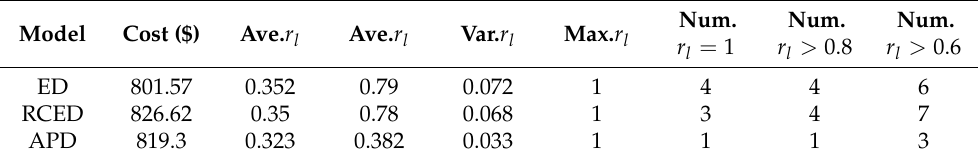
Table 1. Comparison of power flow distribution indices of different power dispatch models tested on the IEEE 30-bus